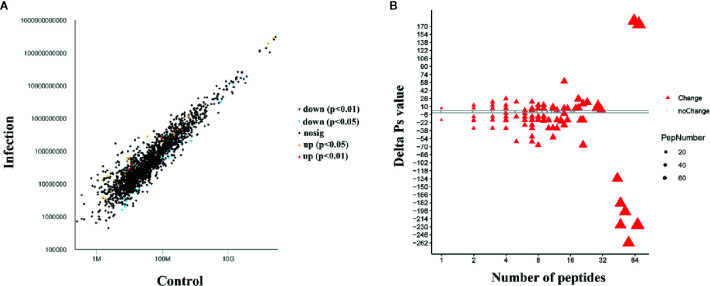
Differentially abundant peptides (DAPs) and differentially expressed protein (DEP) analysis at 24 hpi with Gram-negative bacteria. (A) Visualization of differential abundant peptides at 24 hpi. Down and up indicate down-regulated expression and up-regulated expression, respectively. P < 0.05 and P < 0.01 represent significant differences and extremely significant differences, respectively. (B) Quantitative ΔPs analysis between the infection group and control group. Red triangles indicate differential expression, and gray dots indicate no significant difference. The threshold is |ΔPvalue| > 2.